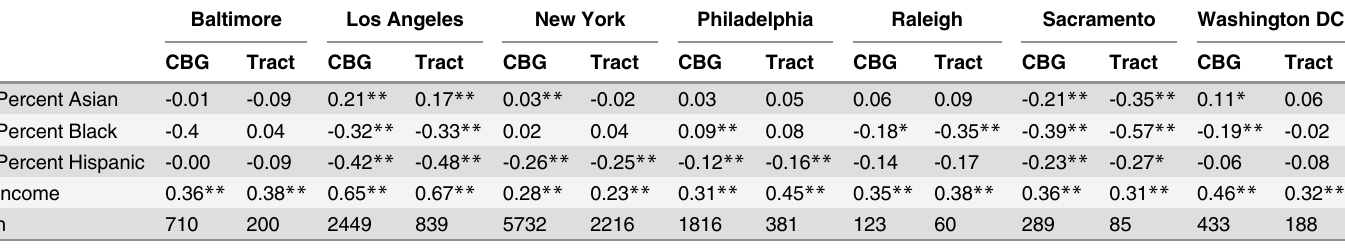
Table 3. Spearman ’ s Correlation